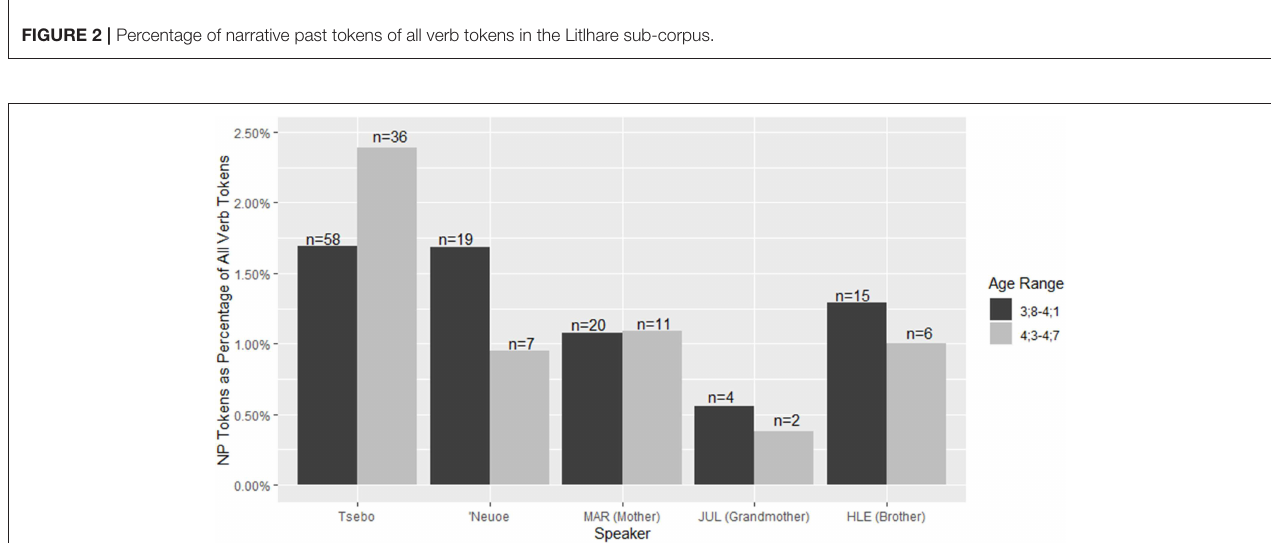
FIGURE 3 | Percentage of narrative past tokens of all verb tokens in the TseboNeuoe sub-corpus.